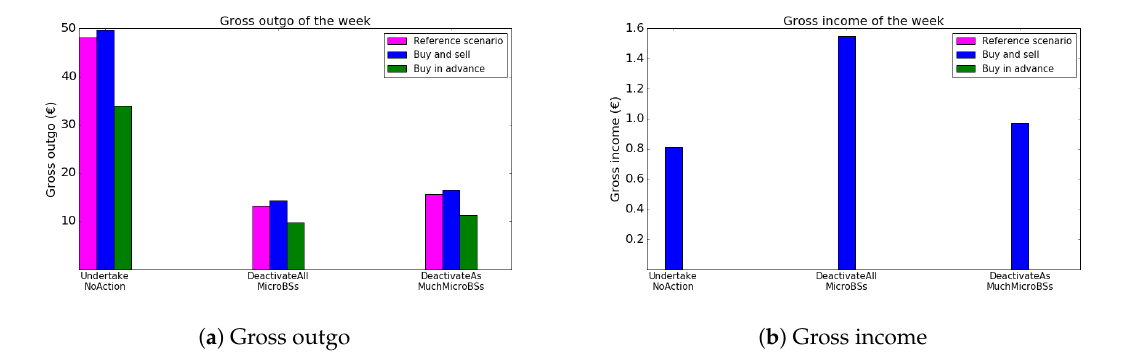
Figure 9. Gross outgo ( a ) and gross income ( b ) obtained using energy- and cost-reducing actions of Strategy 1.